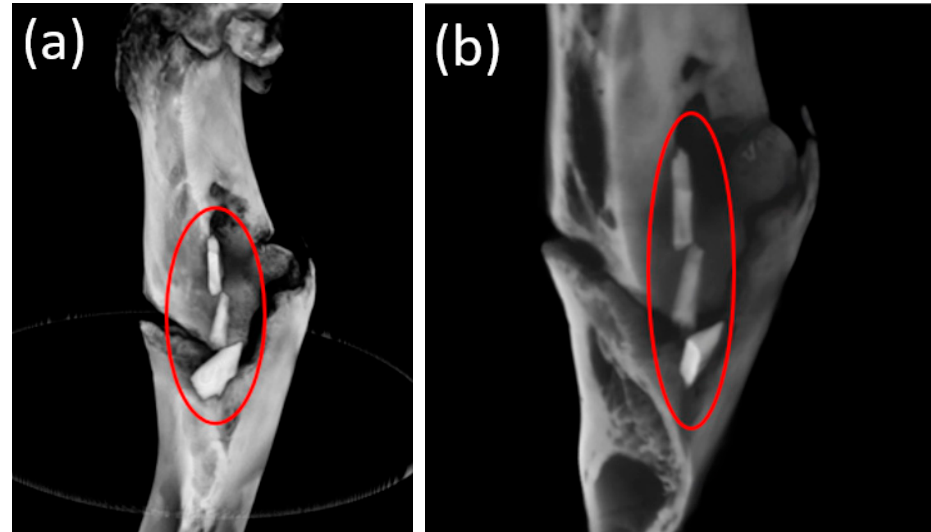
Figure 11. ( a,b ) Image of a fragment of the femur of an animal and the implant 1 month after im- plantation (obtained using micro-CT).